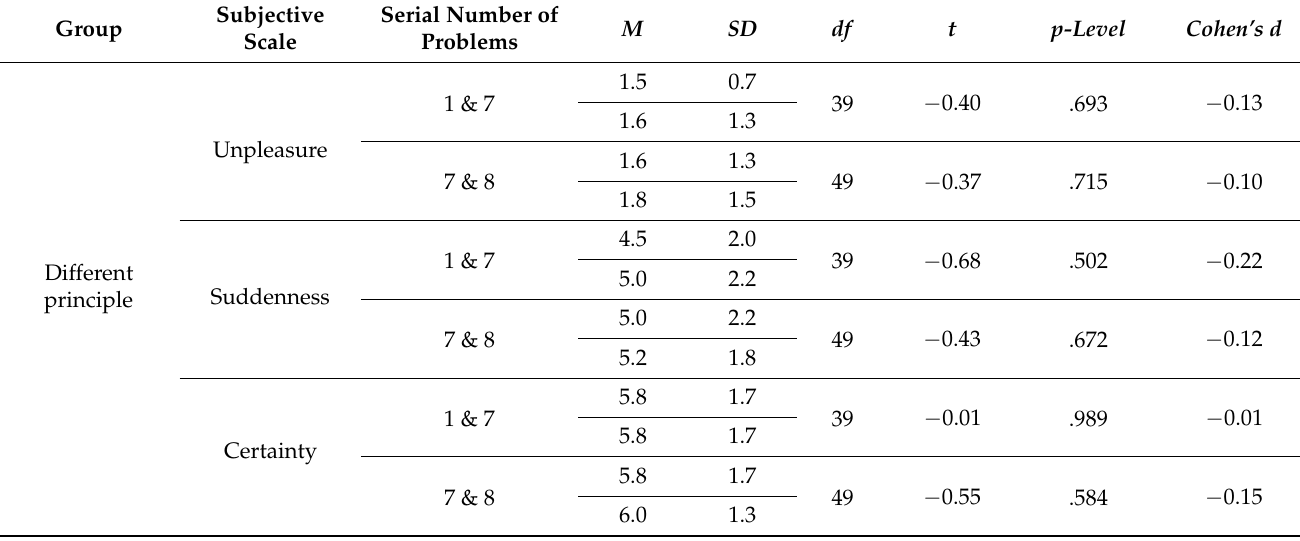
Table A2. Independent t -test of subjective